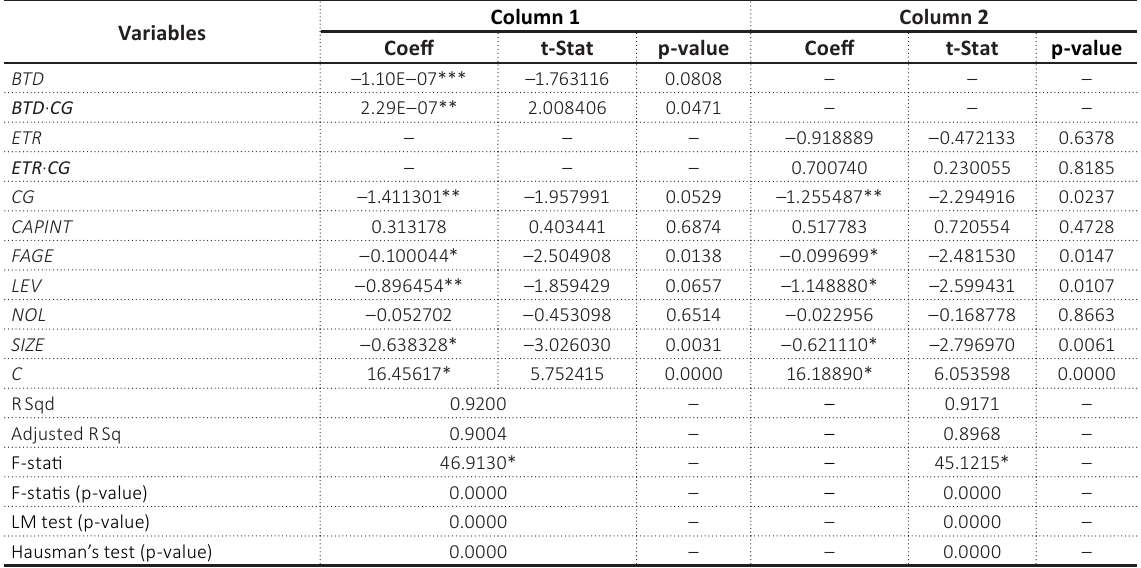
Table 3. Panel estimation